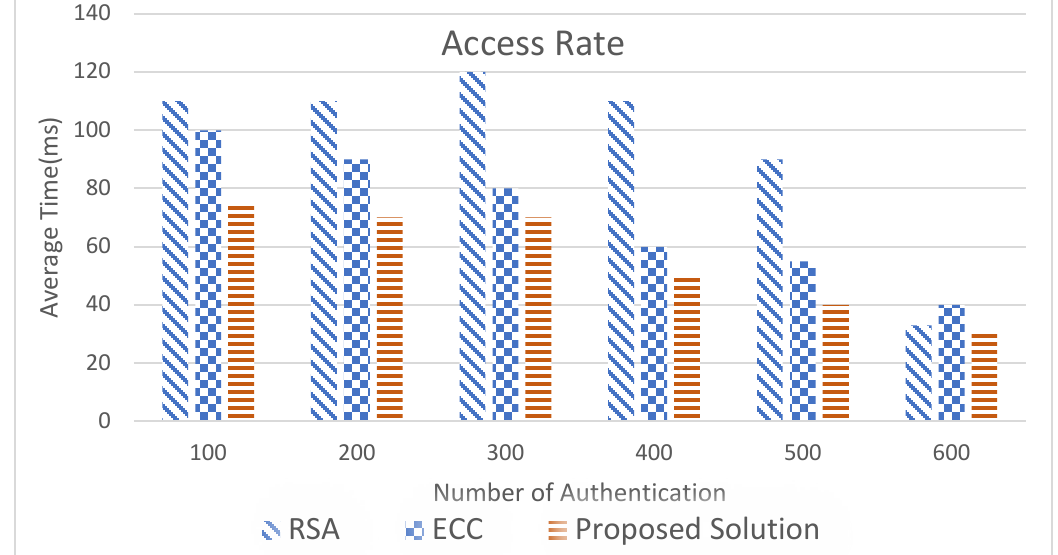
Figure 13. Access rate of authentication.